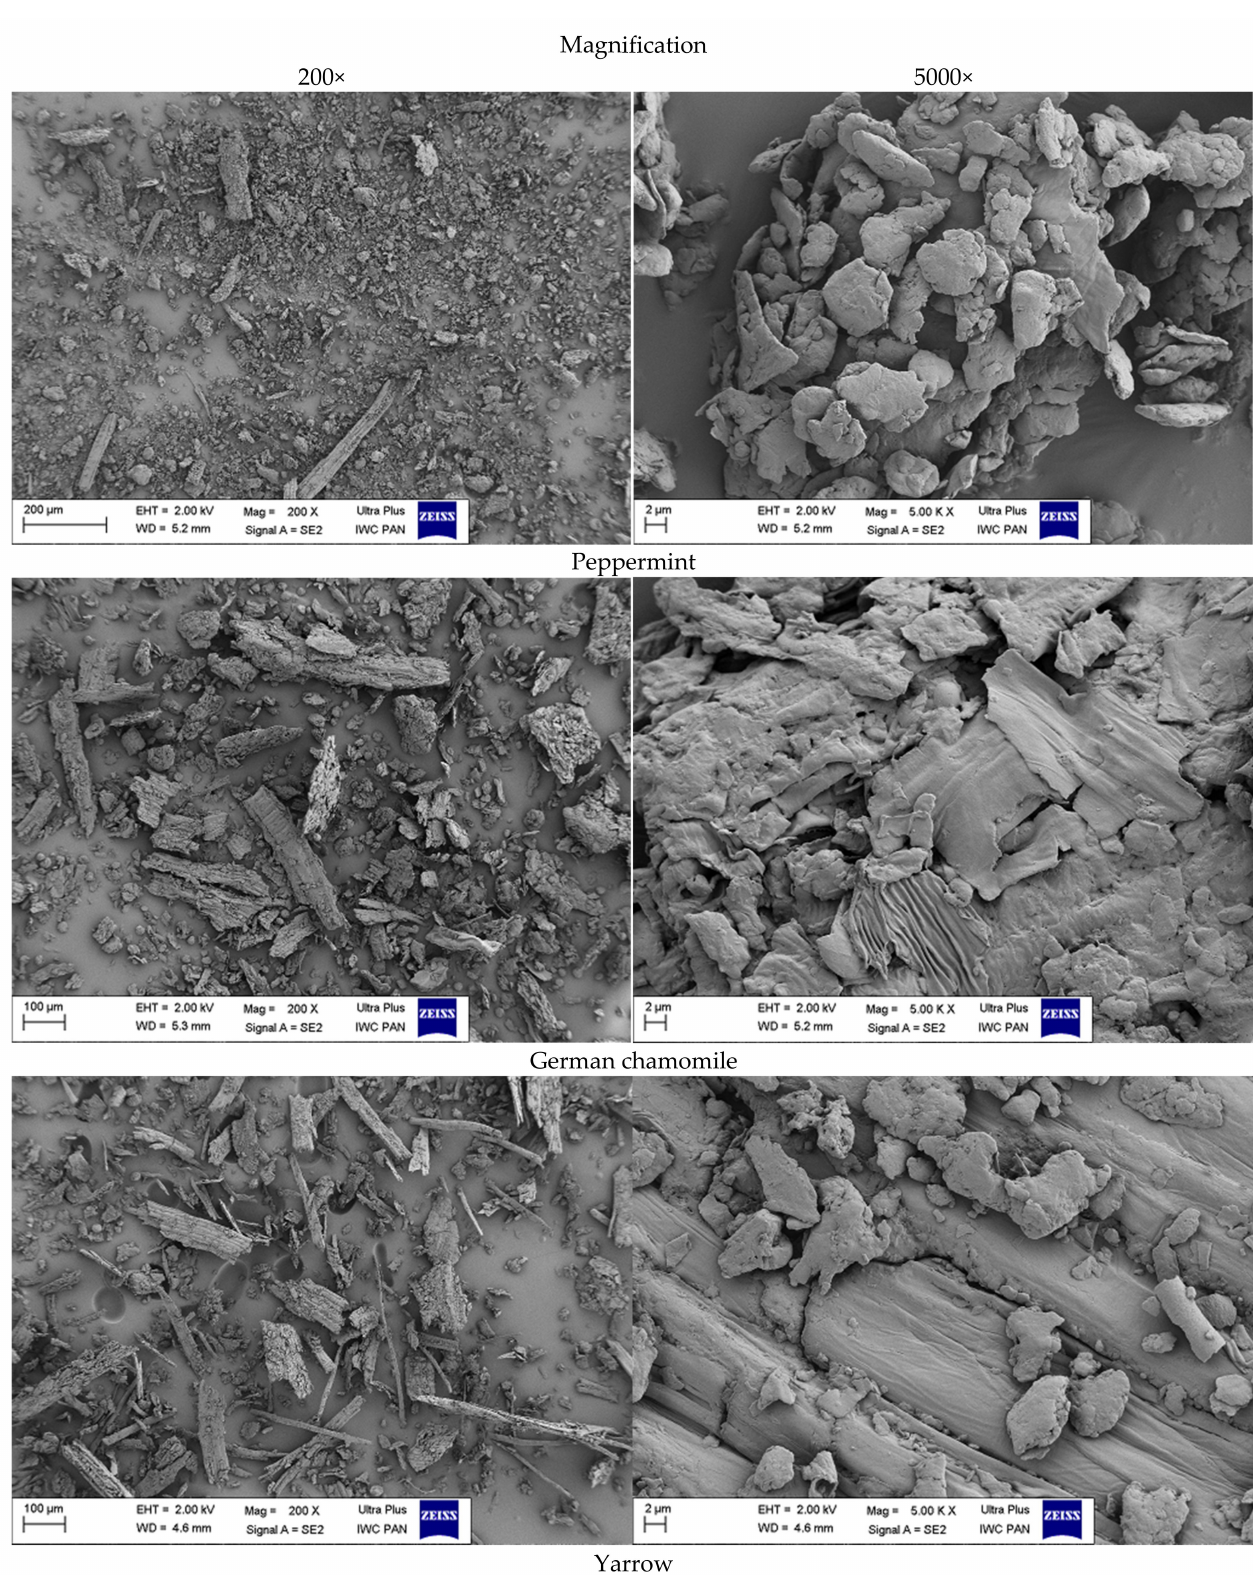
Figure 5. SEM images of fillers at the 200 × and 5000 ×